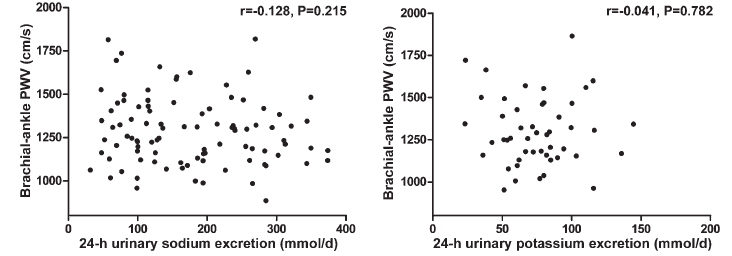
Figure 2. Correlation between brachial-ankle pulse wave velocity (PWV) and 24-h urinary sodium excretion in all subjects on low-salt and high-salt diets, and potassium excretion of sub- jects on a high-salt diet with potassium supple-